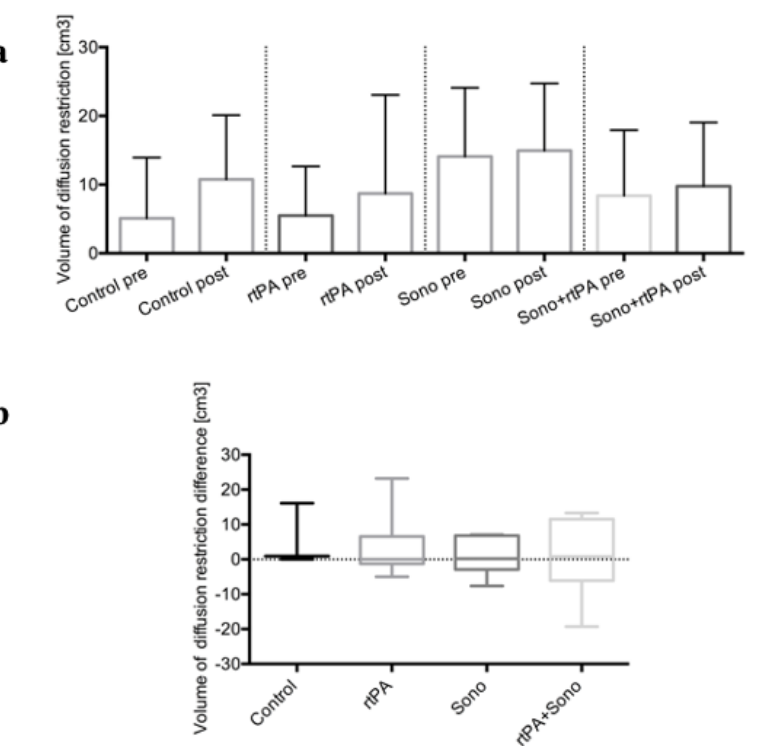
Figure 3. Cranial MRI (control group n = 3; treatment groups (2 – 4); each n = 6); ( a ) Volumes of diffusion restriction [cm3] ( y -axis) of the different groups (1 – 4) ( x -axis) before and after treatment are illustrated as a column bar graph plotting mean and SD. ( b ) Volumes of diffusion restriction difference [cm3] ( y -axis) of the different groups (1 – 4) ( x -axis) after treatment are depicted as box plots.